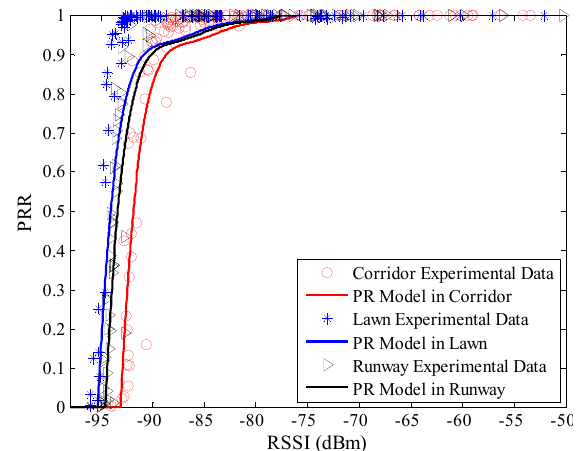
Figure 11. Effects of PR (polynomial regression) model in different environments.